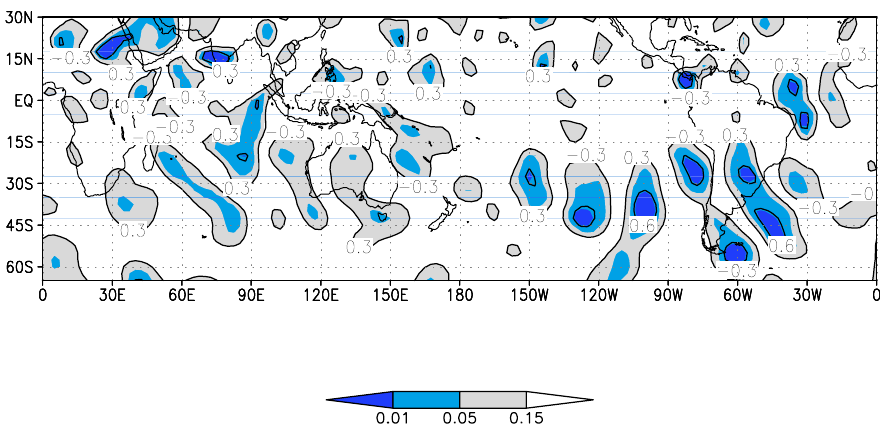
Figure 11: Fig. 11. Correlation fields between the average surface temperature over the Wet Pampa area during GF events and the global meridional wind at 250hPa (lag 0). Only significant values at the 95% level are shown and indicated by the shaded contours.